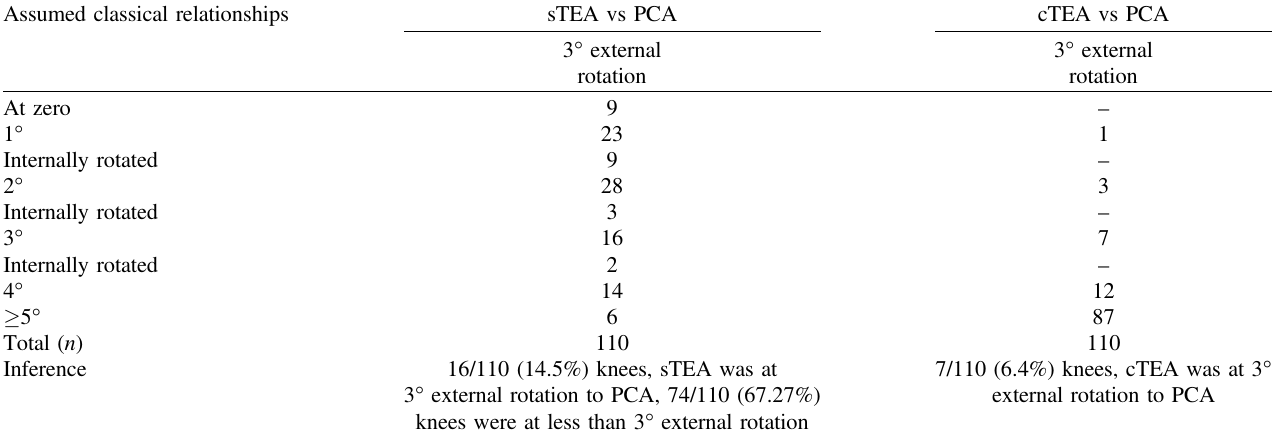
Table 3. Proportion of patients who vary from the assumed PCA to TEA relationship.